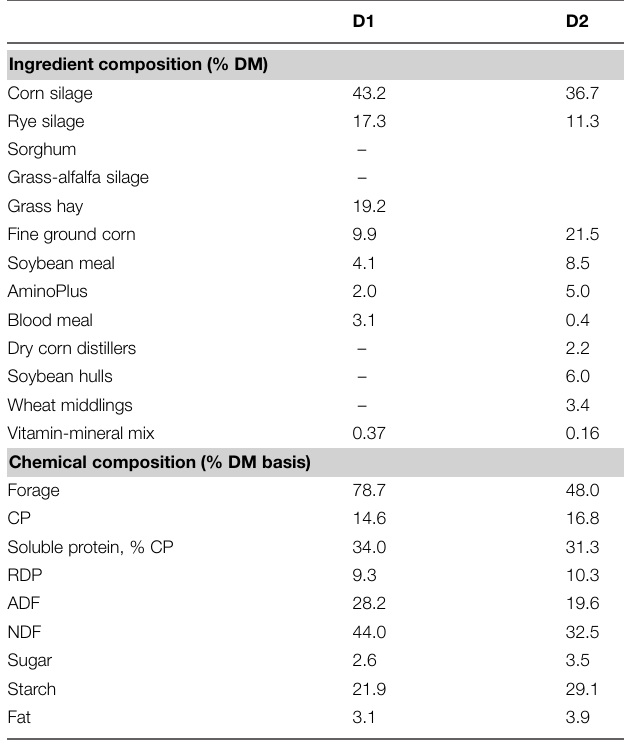
TABLE 1 | Nutrient composition of high forage (Pre-calving: D1) and high energy (Post-calving: D2)